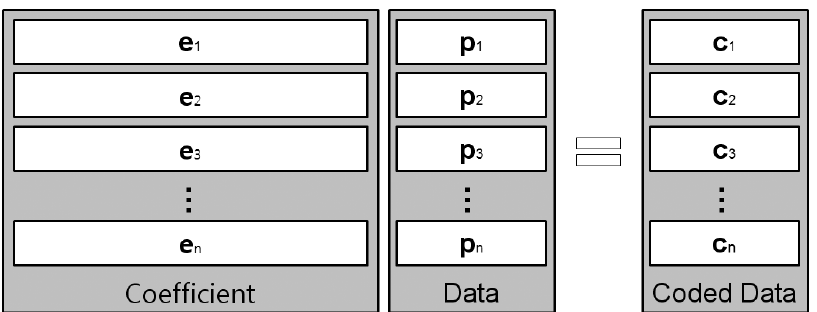
Figure 3. Data encoding at the sending node.